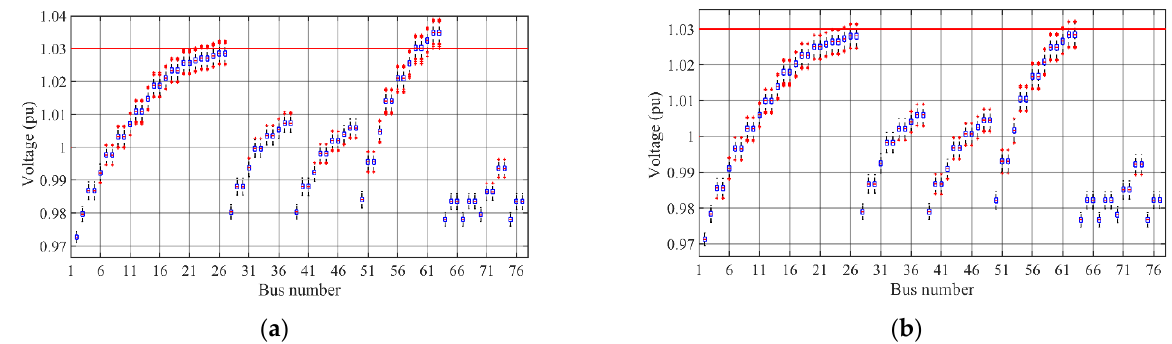
Figure 4. Voltage results obtained by the CC voltage control framework: ( a ) CC-Method I; ( b ) CC-Method II.